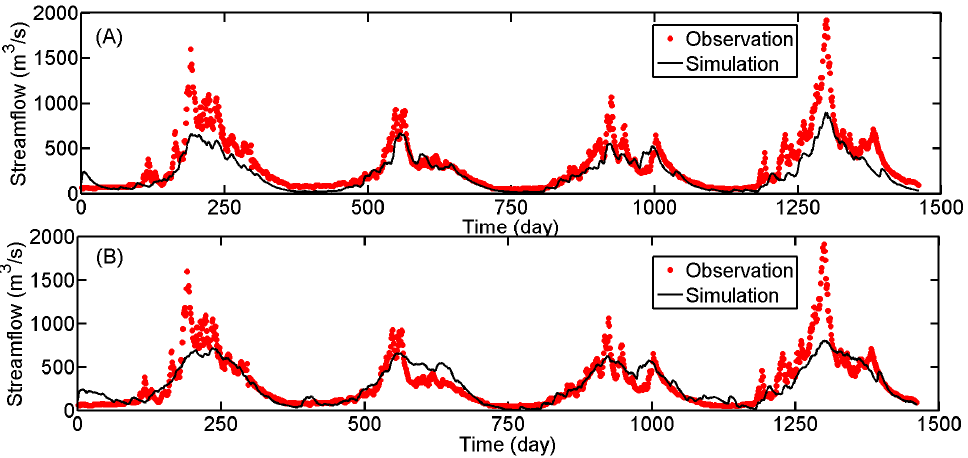
Figure 7. Daily observed streamflow at the outlet of the Ganzi Basin for both: ( A ) Open Loop HBV simulated results obtained without data assimilation and ( B ) case C10 data assimilation results between 1 January 2010 and 21 December 2013.